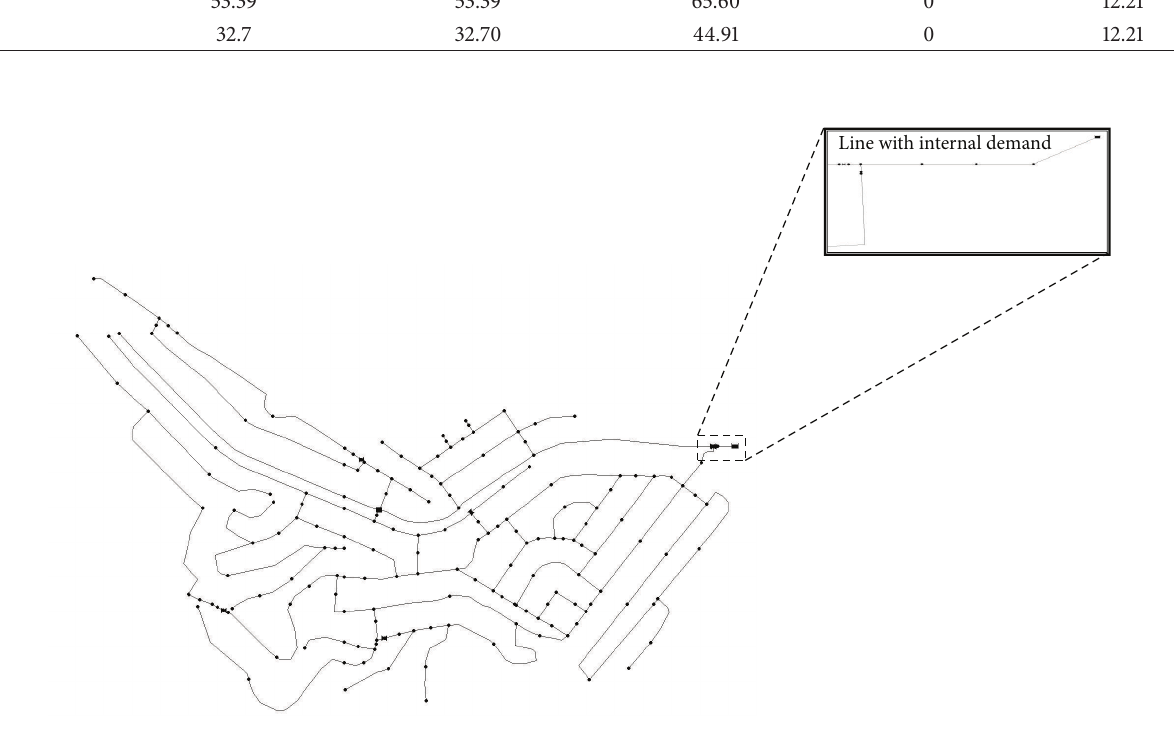
Figure 7: Water supply system used for the practical example.